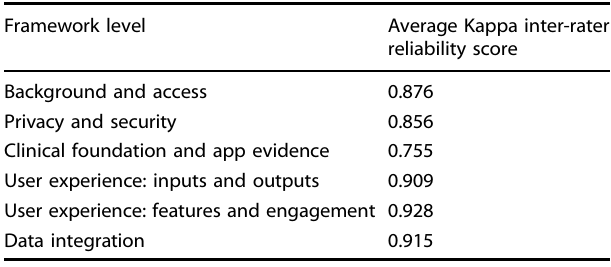
Table 1. The average interrater reliability at each level of the APA